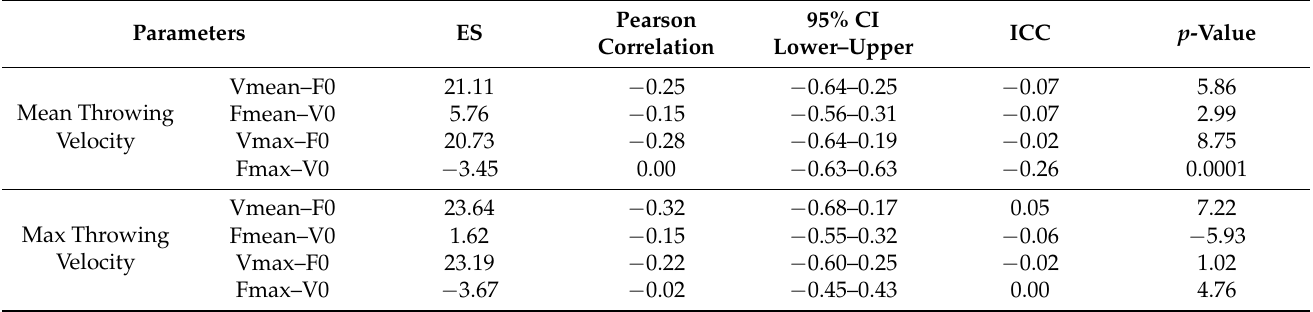
Table 2. Correlations between different force variables and average and peak throwing velocities.